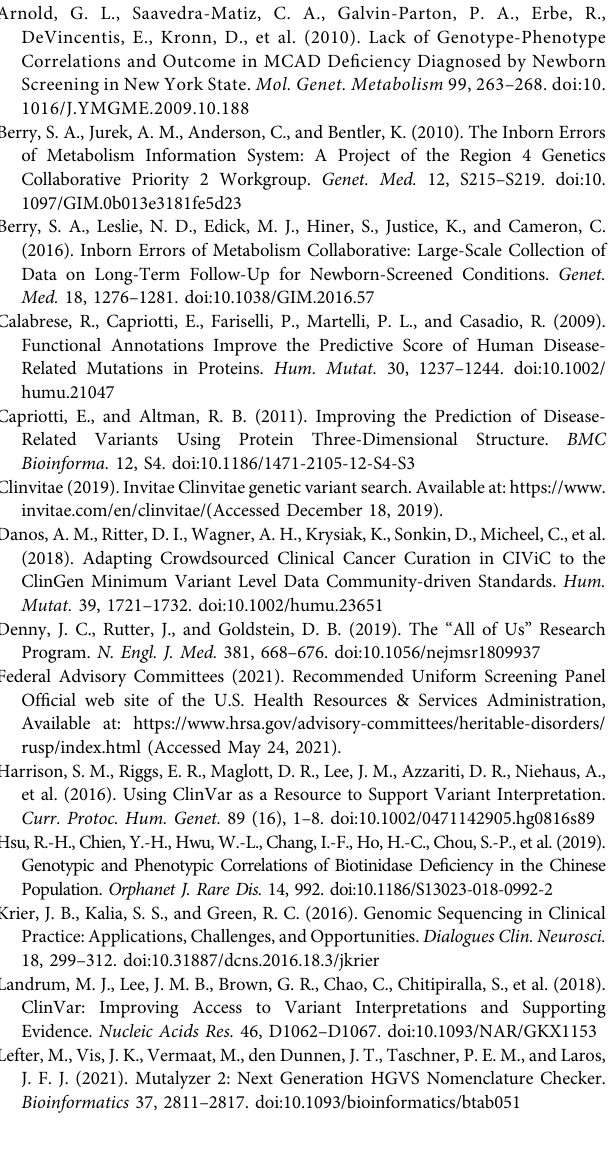
Supplementary Table S5 | Detailed scoring assessment for each unpublished variant identi fi ed from the